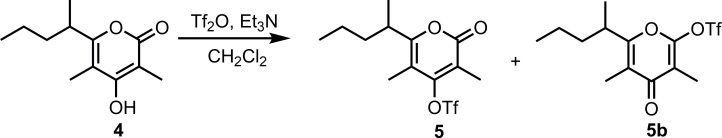
Triflation of 4 with triflic anhydride.